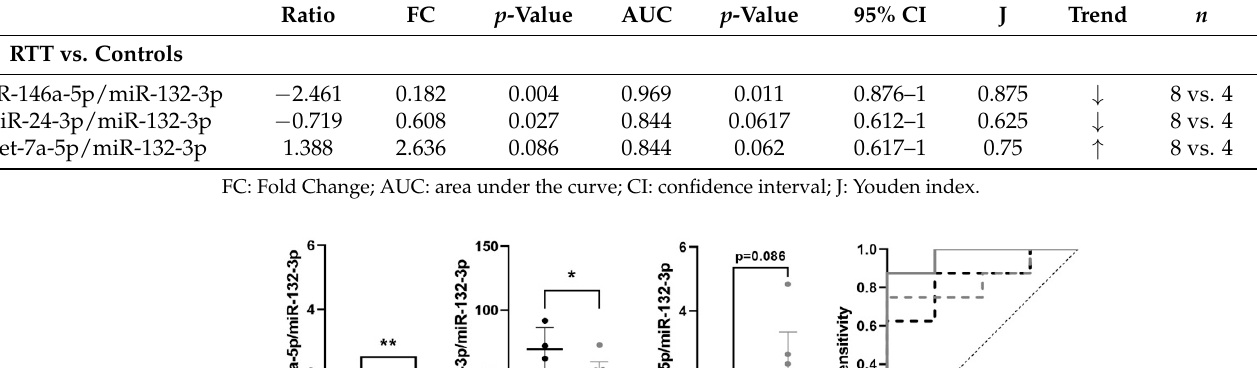
Ratio FC p -value AUC p -value 95% CI J Trend n Ratio